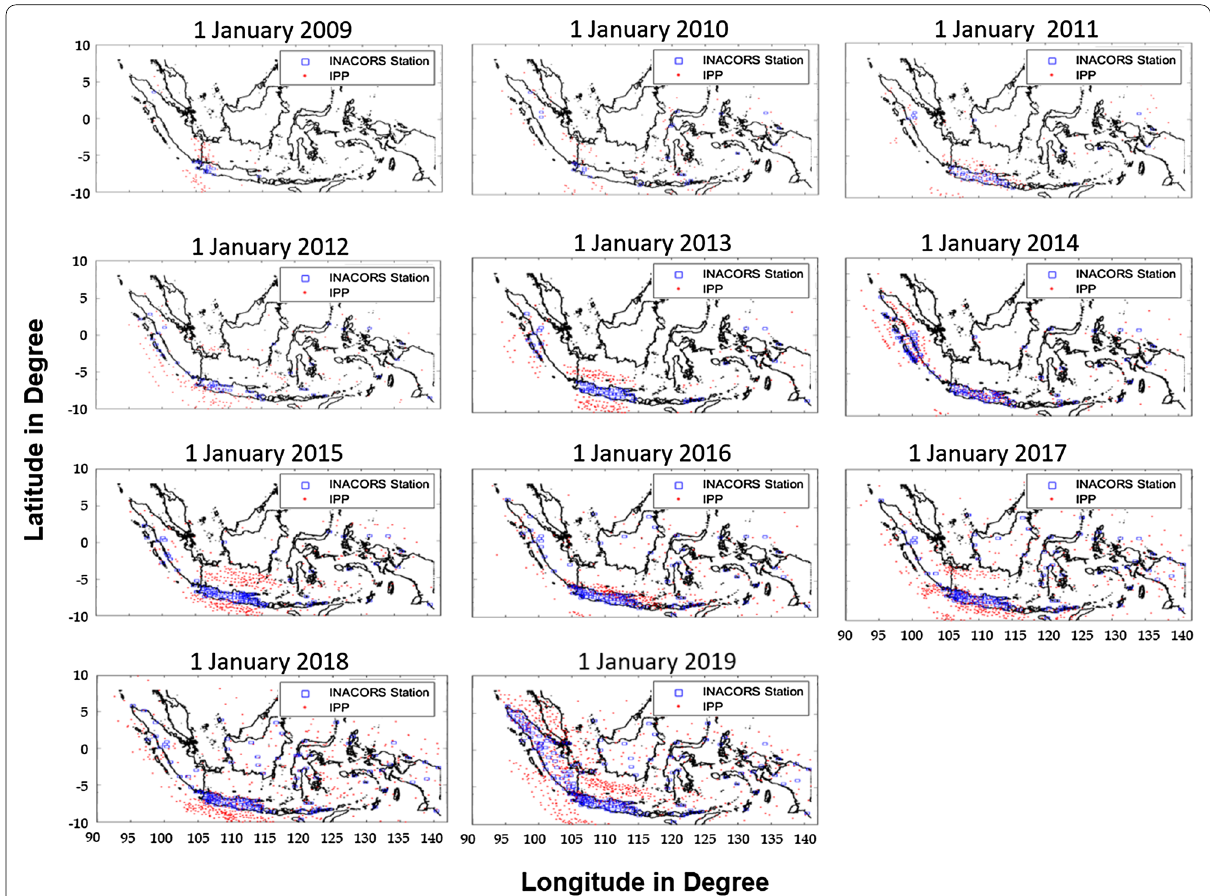
Fig. 1 Distribution of CORS stations (blue) from 2009 to 2019 and their IPPs with an elevation angle of 30° (red) at 0 UT or 7 local time on 1